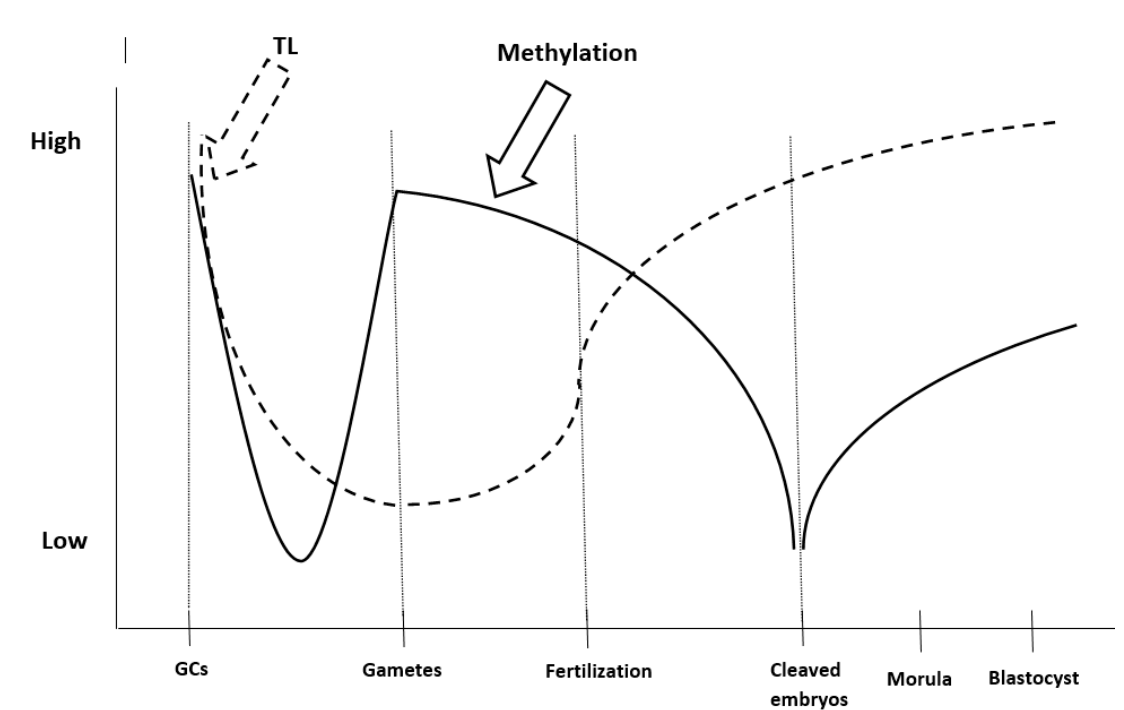
Figure 1. Telomere length reprogramming and methylation—de-methylation cycle during gametogenesis and early embryo development. The dot line represents the telomere shortening-lengthening, while the continuous line describes the methylation—de-methylation cycle taking part during the stages described above. GCs; Germ Cells, TL; Telomere Length.